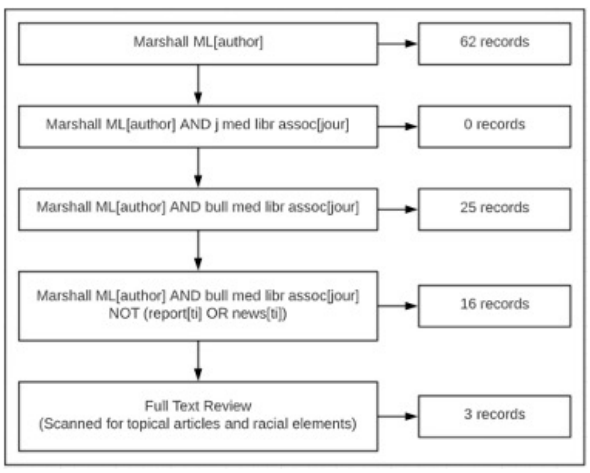
Figure 2 Literature search flow